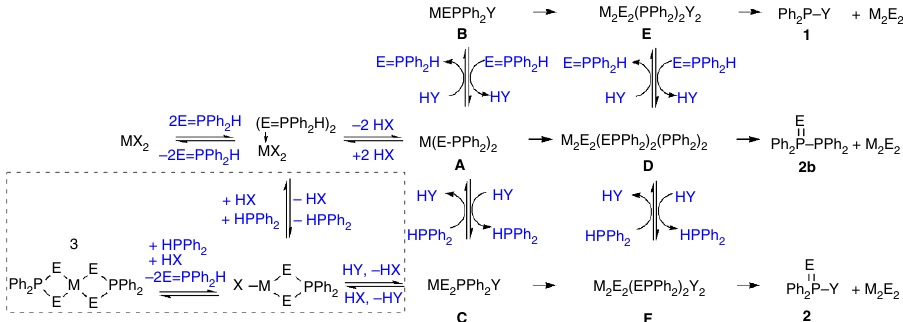
Figure 6 | Schematic of the general pathway for formation of M 2 E n monomers. For simplicity, this figure is drawn for M (II) only at low temperature from metal carboxylate ( MX 2 ) and dialkylphosphine chalcogenide ( E ¼ PPh 2 H) with the use of additive H Y . Specific schemes for the other metal valences can be constructed accordingly. E ¼ S, Se or Te. When H Y ¼ R COOH ( a ), HPPh 2 ( b ), R NH 2 ( c ), R SH ( d ) and R OH ( e ), Compounds 1 and 2 are labelled as 1a – e and 2a – e , respectively. The equilibrium of 1 þ E ¼ PPh 2 H " 2 þ HPPh 2 is worthy of notice (Supplementary Table 2 and Supplementary Note 2). Note that another secondary phosphine, dicyclohexylphosphine (HPCy 2 ), was also tested (as shown in Supplementary Figs 1 and 3); precursor E ¼ PCy 2 H instead of E ¼ PPh 2